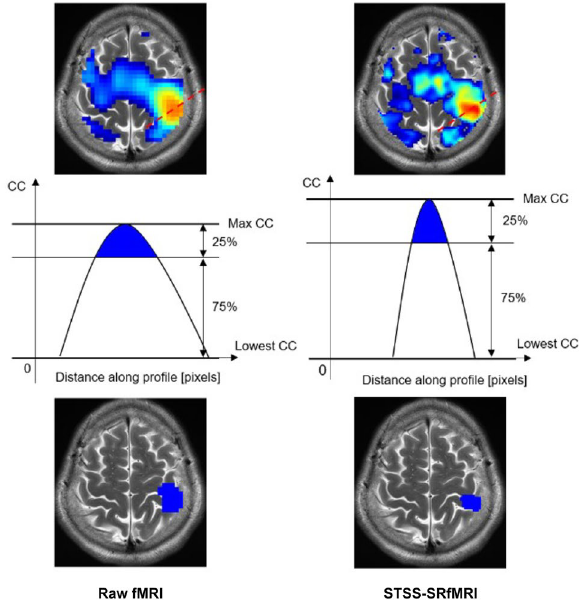
Figure 2. Overview of how the activation-related region was defined for each tapping task. First the activation maps were obtained from the raw and the Static T2*WI-based Subject-Specific Super Resolution fMRI (STSS- SRfMRI) image series (top row). Second, the top 25% between the max and minimum CC values was set as the threshold (middle row). Finally, the region consisting of pixels having values equal to or higher than the threshold value was defined as the activation-related region (bottom).